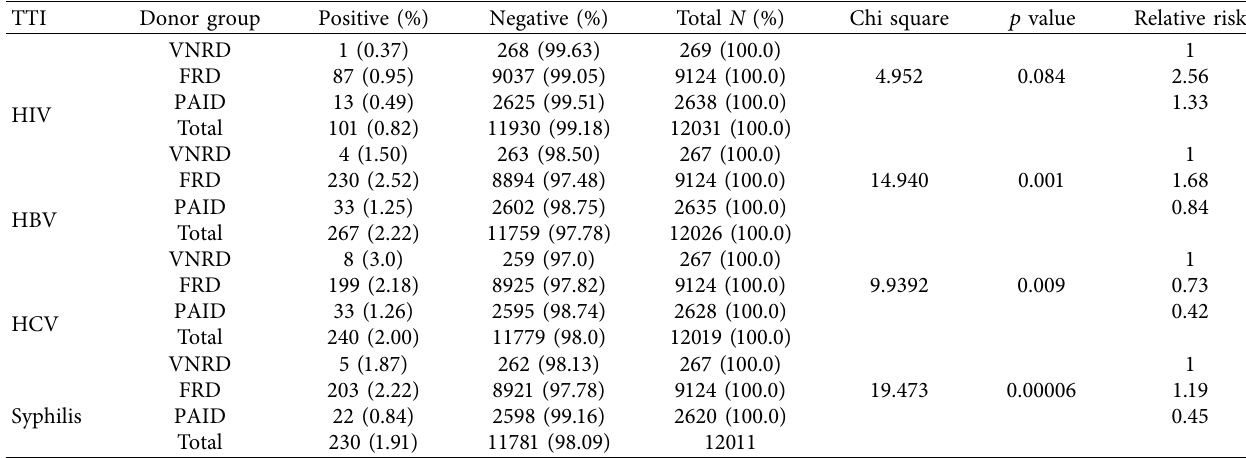
Table 4: Seroprevalence of blood-borne diseases among persons screened during the study period.